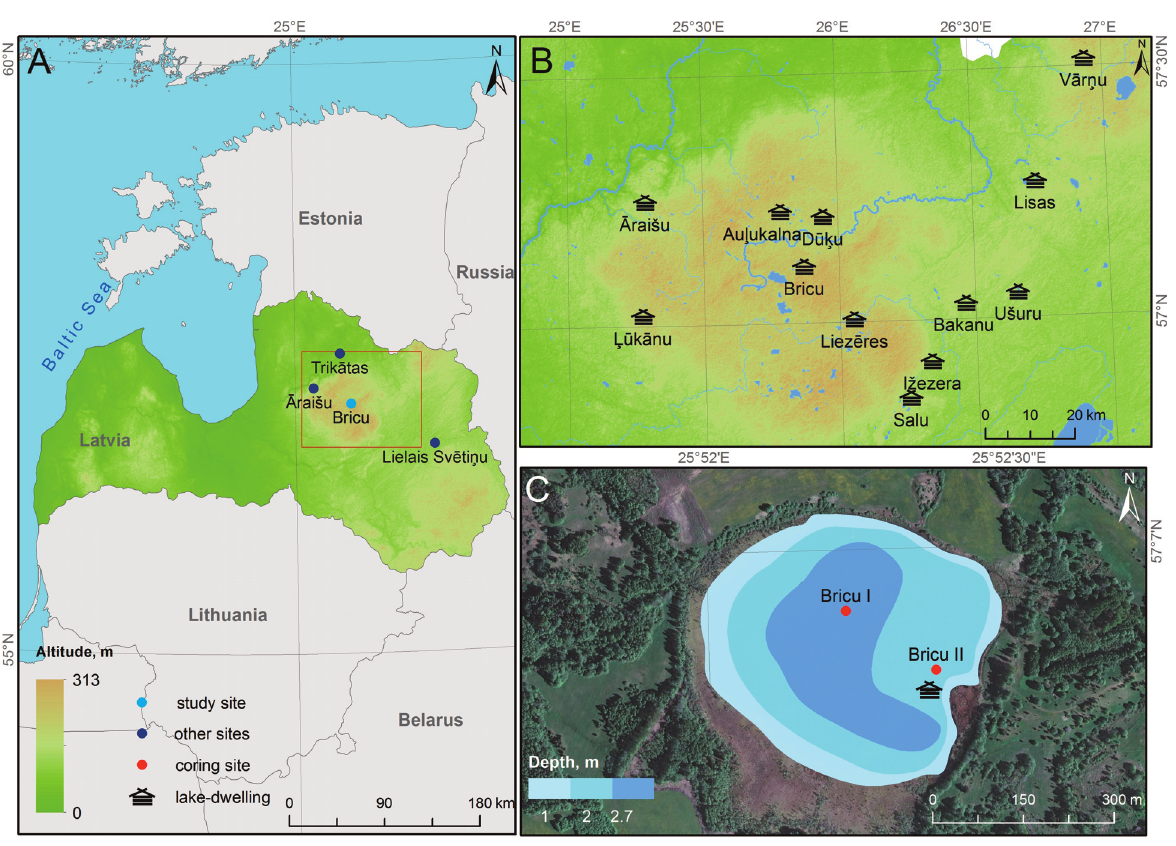
Fig. 1. Location of the study area in northeastern Europe and sites discussed in the text: A , Lake Lielais Svētiņu (Stivrins et al. 2015b; Feurdean et al. 2017), Lake Āraišu (Stivrins et al. 2015b) and Lake Trikātas (Stivrins et al. 2016a); B , Lake Bricu and other lakes in central Latvia where dwelling sites have been found; C , coring sites and the setting of Lake